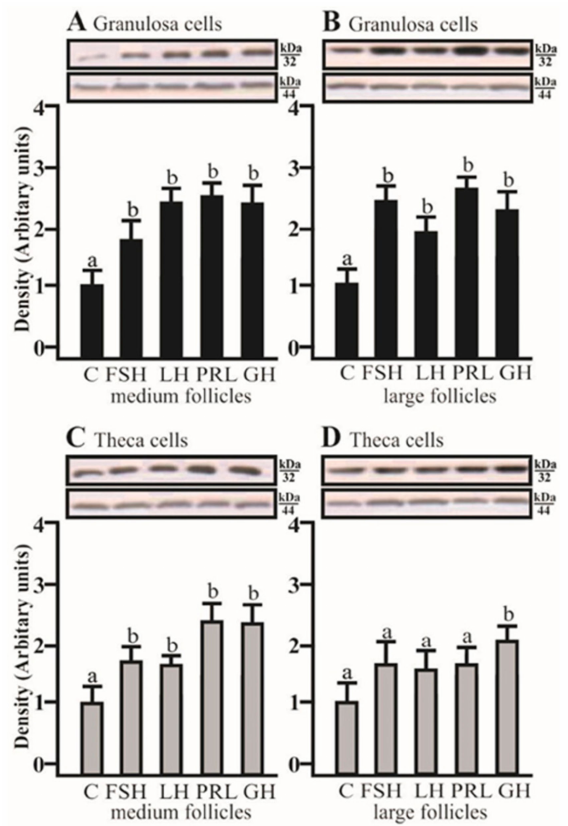
Figure 4. The changes in the expression of AQP5 (kDa 32) protein in porcine Gc and Tc obtained from MF and LF after 24 h co-culture of these cells in the absence (C) or presence of follicle-stimulating hormone (FSH), luteinizing hormone (LH), prolactin (PRL), and growth hormone (GH). The samples were subjected to Western blot analysis and normalized to the expression of β -actin (kDa 44), ( A , B ) in the Gc and ( C , D ) Tc. Values are expressed as means ± S.E.M from five separate experiments, each performed in triplicate ( p < 0.05 compared with controls). Statistically significant di ff erences between treatments are indicated by di ff erent letters (a, b). C: